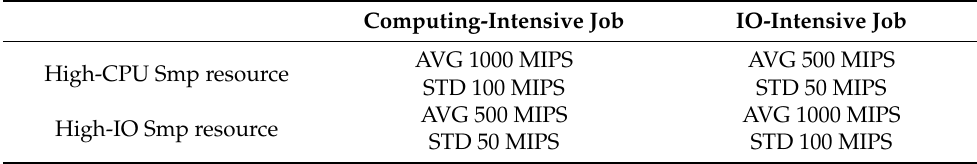
Table 3. Average processing capacity of security middle platform